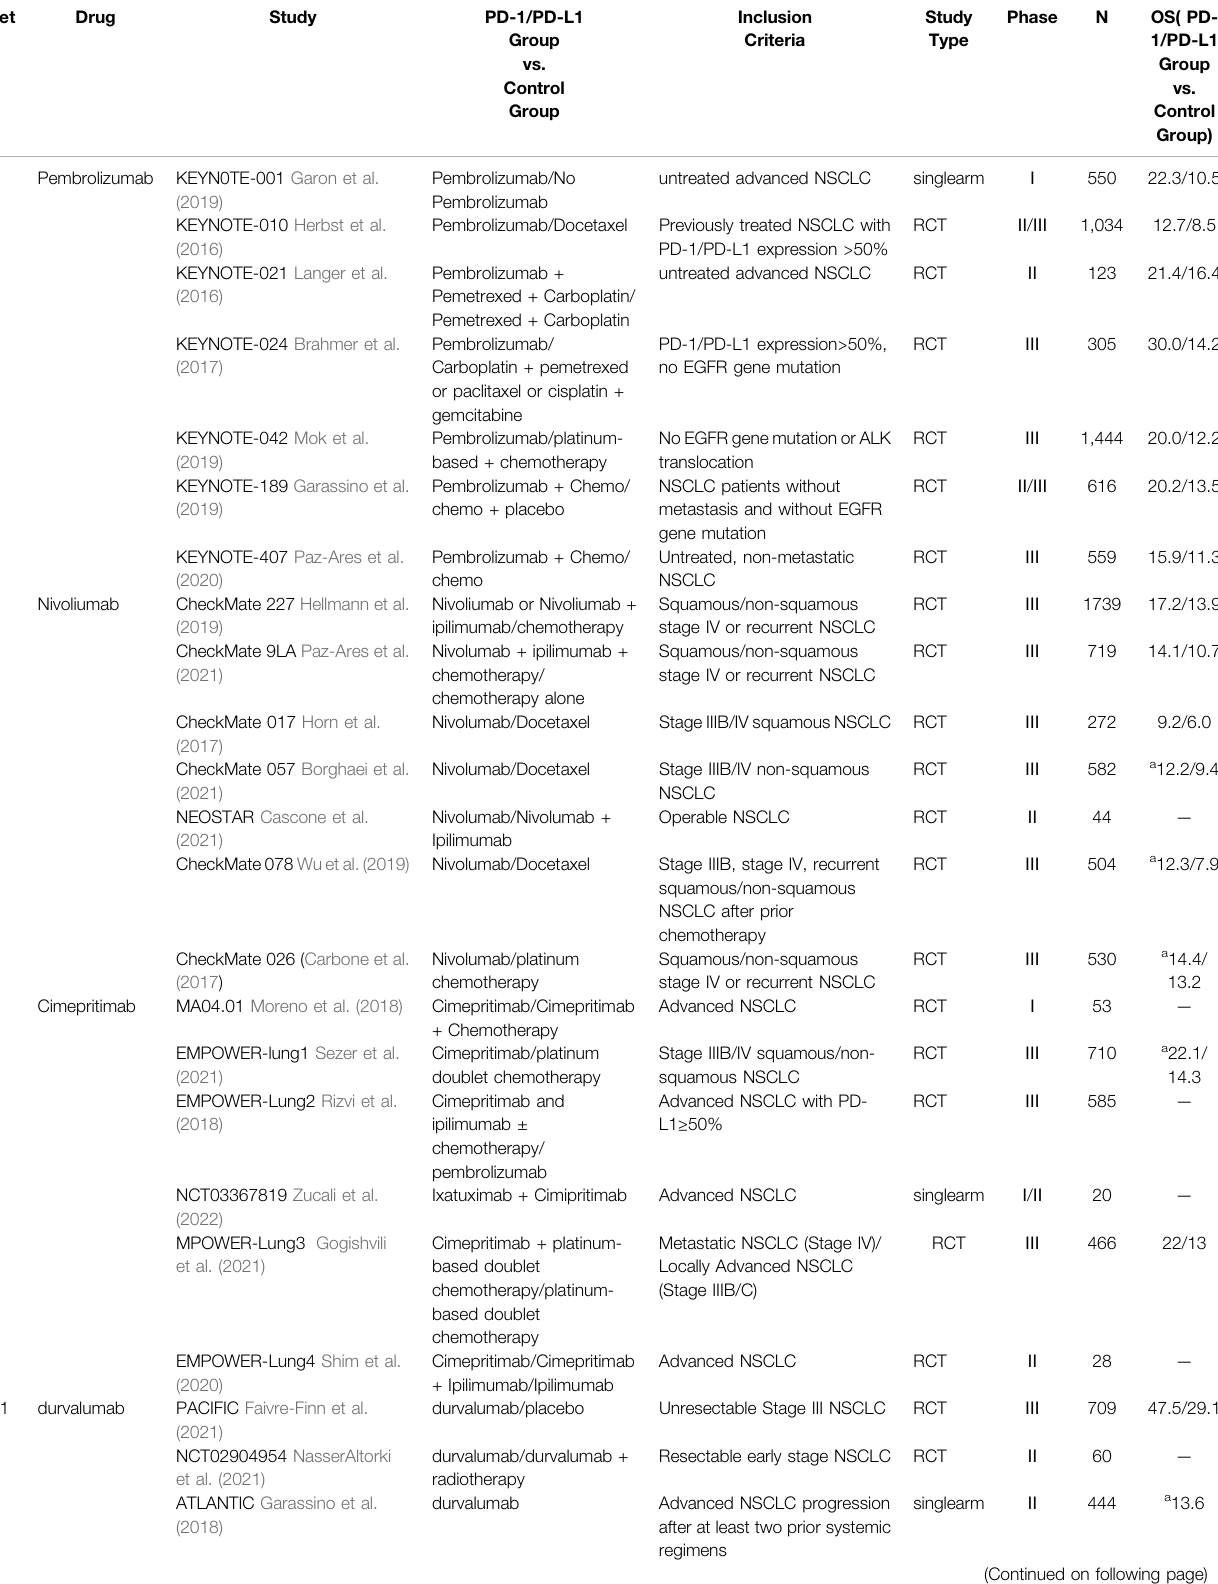
TABLE 3 | FDA/EMA/NMPA-approved NSCLC treatments of PD-1/PD-L1 blocking antibodies clinical trials.